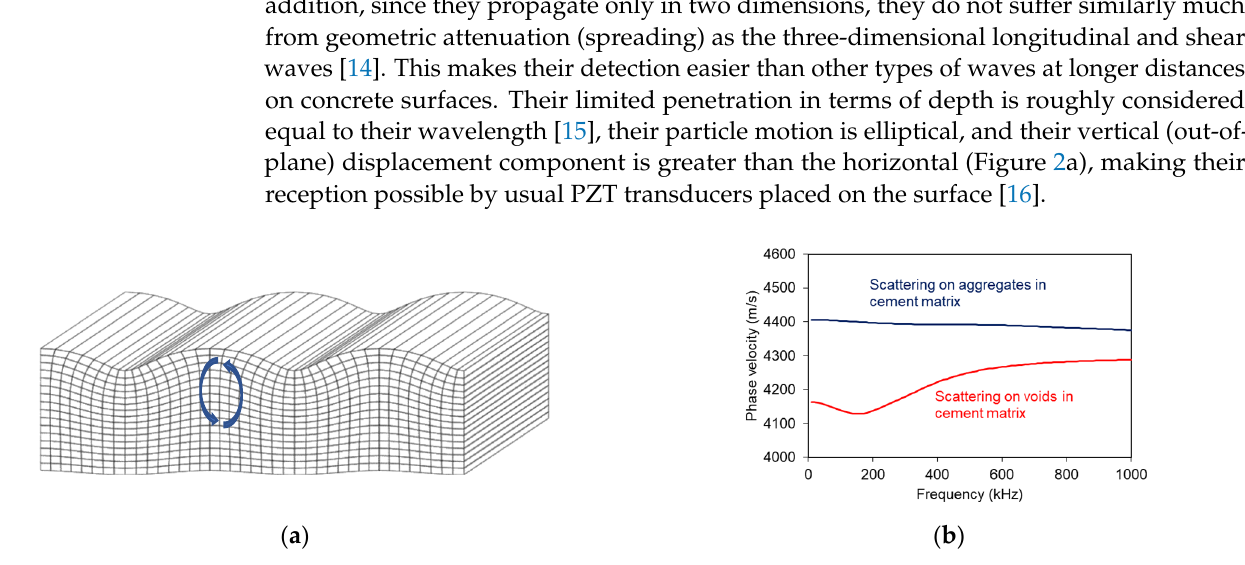
Figure 2. ( a ) Schematic representation of a Rayleigh wave on the surface of a medium [17] (the blue arrows stand for the ellipsoidal particle motion) and ( b ) phase velocity vs. frequency curve for the cases of stiff particles and voids in a cementitious matrix (theoretical results using the scattering model of Waterman and Truel [18]).